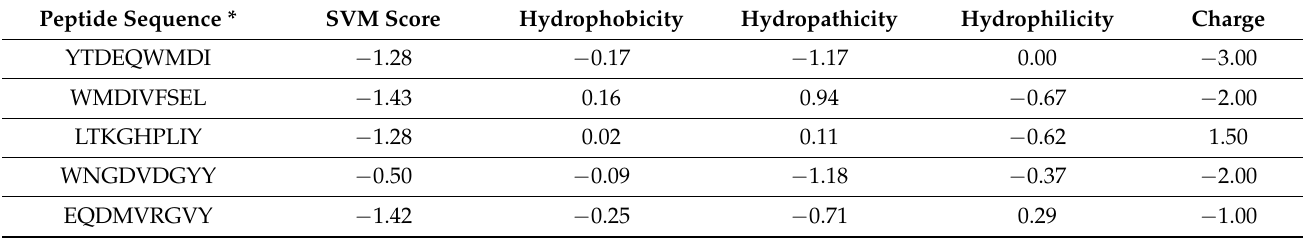
Table 5. Toxicity prediction of epitopes. Table 5. Cont .